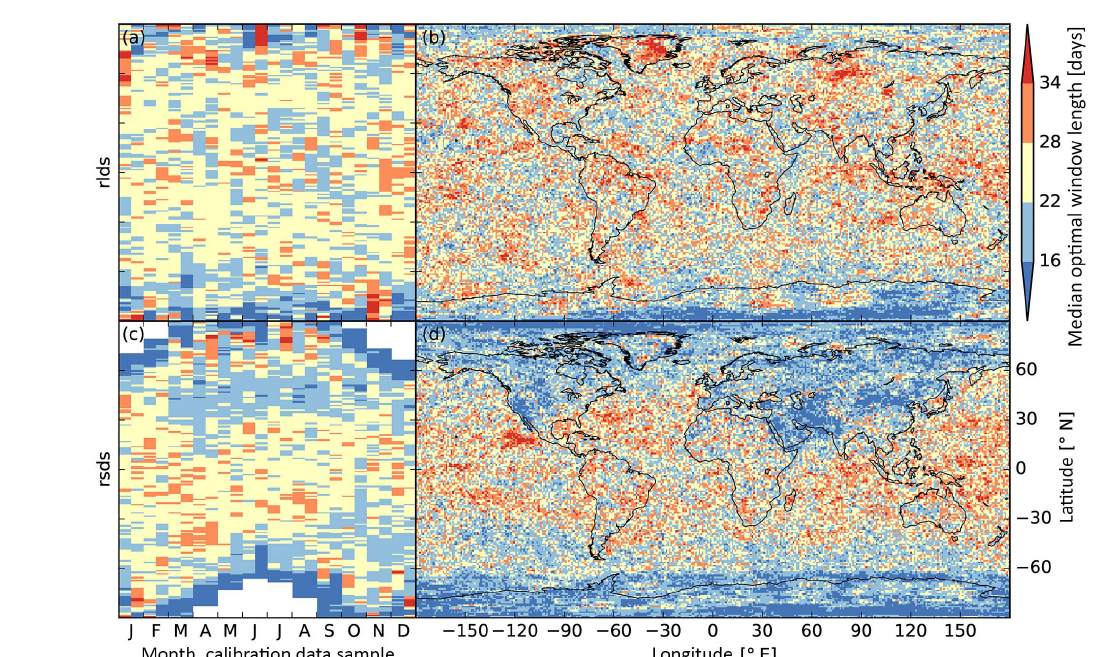
Figure D1. Optimal window length for running mean and maximum calculations that precede the estimation of parameters of the clima- tological distributions of longwave ( v = l; top) and shortwave ( v = s; bottom) radiation that are used for bias correction with BC v da1 (see Table 1). Window lengths are varied between 10 and 40 days. Optimal window lengths maximise the p value of the two-sample KS statistic of bias-corrected E2OBS data cross validated against SRB data (see Sect. 4 and Appendix C) and are determined individually for every grid cell, calendar month (with all corresponding values pooled into one distribution), and calibration data sample (every1st, every2nd). Zonal medians of optimal window lengths for each month and calibration data sample are shown in panels ( a ) and ( c ). Results are masked in ( c ) where and when the monthly mean rsdt (Eqs. B1–B4) is less than 1Wm − 2 . Panels ( b ) and ( d ) show medians of optimal window lengths over months and calibration data samples.